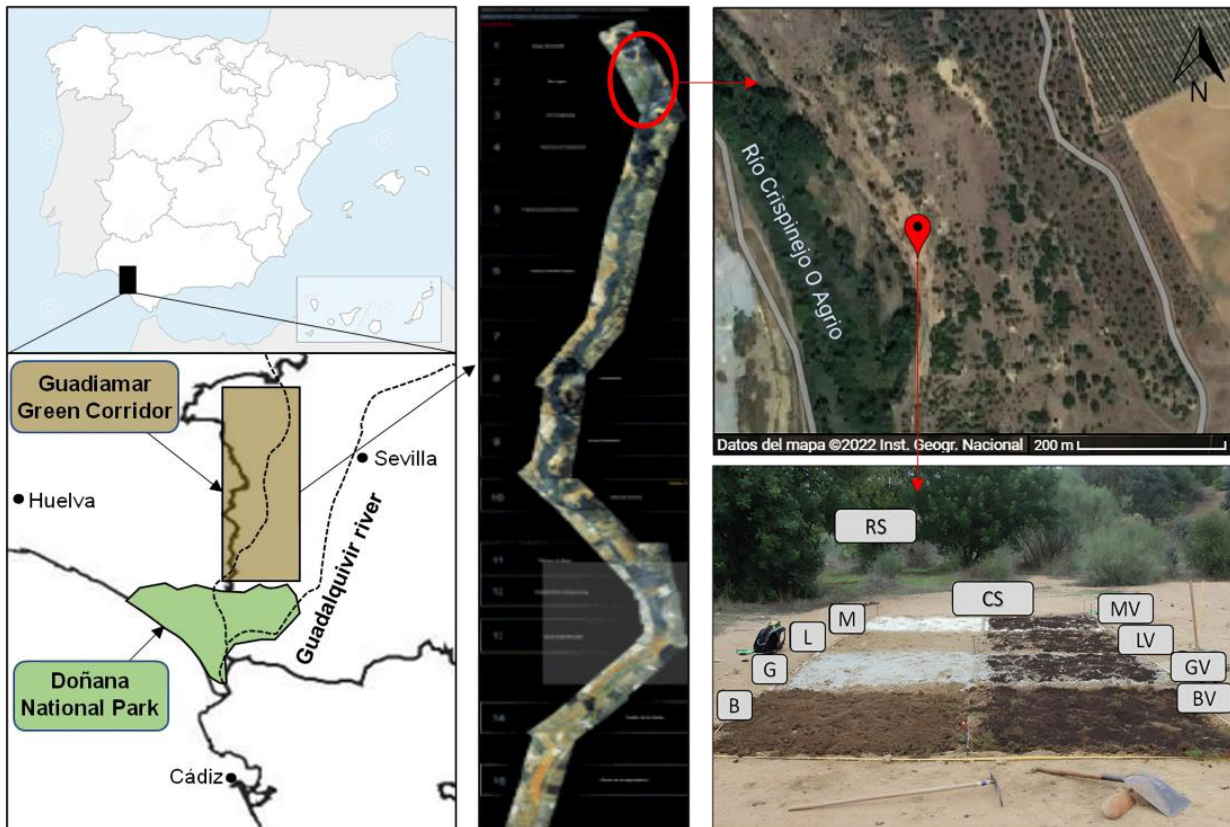
Figure 1. Study area, plot localization in the unvegetated soil nearby to the mine and treatments used for the remediation.